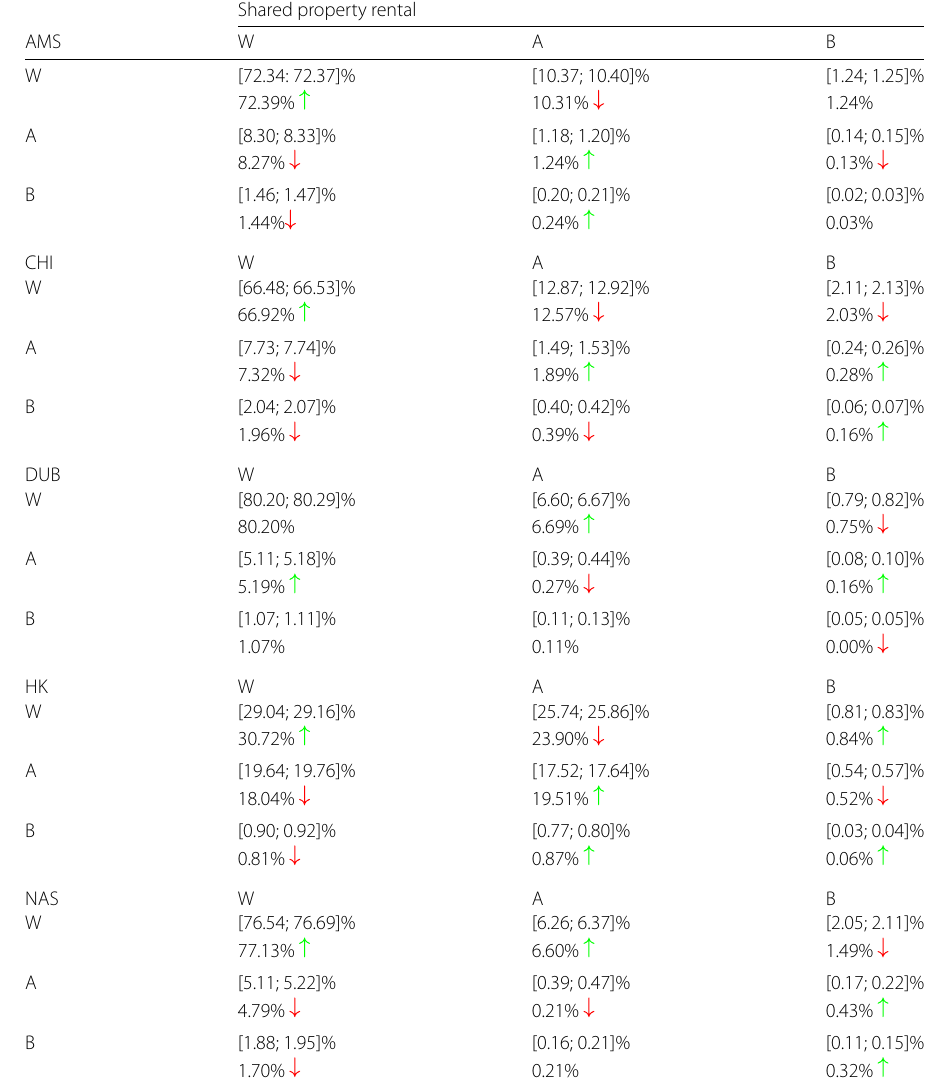
Table 7 Pairings between racial backgrounds of Airbnb guests and hosts (W = White, A = Asian, B = Black) in shared property rentals. Values in brackets represent 95% confidence level intervals obtained from the rewiring analysis, while values below them denote the corresponding empirically observed frequencies. Upward green (downward red) arrows highlight over-expressed (under-expressed) values Shared property rental AMS W A B W [72.34: